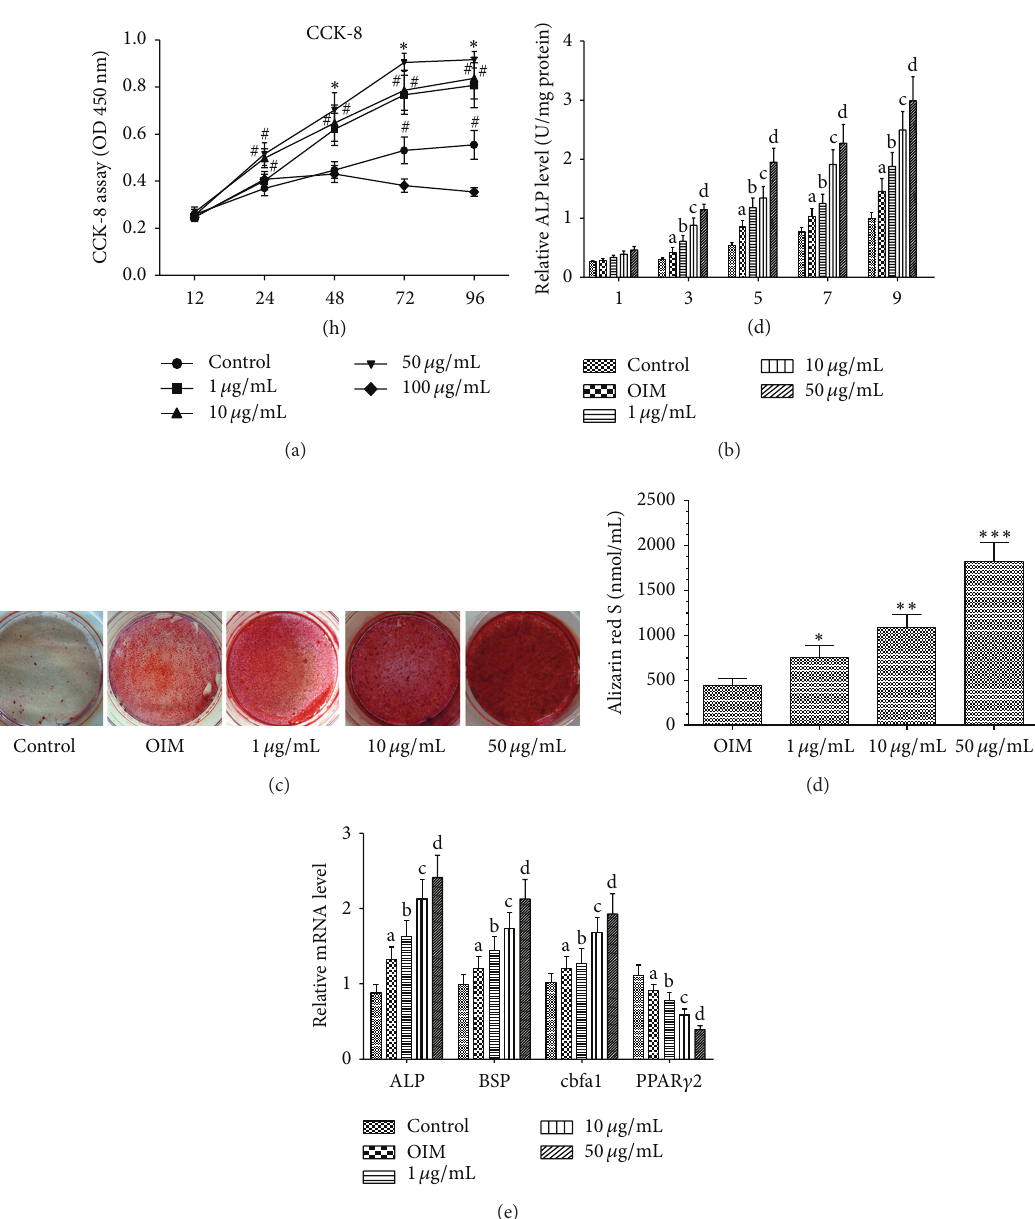
Figure 1: Naringin potentiates proliferation and osteogenic differentiation of BMSCs. (a) BMSCs were cultured in basal medium with or without various doses of naringin (1, 10, 50, and 100 𝜇 g/mL) for 12–96 hours, and the proliferation rate was assessed by CCK-8 assay. Cell proliferation of BMSCs was enhanced by naringin treatment. Naringin showed the most prominent stimulatory effect on proliferation at 50 𝜇 g/mL. Data is expressed as mean ± SD. Experiments were done in quadruplicate ( 𝑛 = 4 ). ∗ 𝑃 < 0.01 versus the control group; # 𝑃 < 0.05 versus the control group at same time point. (b) BMSCs were cultured in basal medium with or without various doses of naringin (1, 10, 50, and 100 𝜇 g/mL) for 1, 3, 5, 7, and 9 days. Data represent the mean ± SD ( 𝑛 = 4 ). ALP activity was measured by the manufacturer’s instructions. a 𝑃 < 0.05 versus the control group at the same time point; b 𝑃 < 0.01 versus the OIM group at the same time point; c 𝑃 < 0.05 versus the 1 𝜇 g/mL group at the same time point; d 𝑃 < 0.01 versus the 10 𝜇 g/mL group at the same time point. (c) BMSCs were cultured in basal medium and OIM with or without various doses of naringin (1, 10, and 50 𝜇 g/mL) for 21 days; then calcium deposits were stained with Alizarin red S solution. For quantitative analysis, the stained samples underwent cetylpyridinium chloride (CPC) extraction (10% CPC) and extracts were measured by spectrophotometry. Data represent the mean ± SD ( 𝑛 = 5 ). ∗ 𝑃 < 0.01 versus the OIM group; ∗∗ 𝑃 < 0.05 versus the 1 𝜇 g/mL group; ∗∗∗ 𝑃 < 0.01 versus the 10 𝜇 g/mL group. (e) BMSCs were cultured in basal medium, OIM, or OIM with 1 𝜇 g/mL, 10 𝜇 g/mL, or 50 𝜇 g/mL naringin for 14 days, and then ALP, BSP, Cbfa1, and PPAR 𝛾 2 mRNA levels were measured by RT-PCR. Data represent the mean ± SD ( 𝑛 = 5 ). a 𝑃 < 0.05 versus the control group; b 𝑃 < 0.05 versus the OIM group; c 𝑃 < 0.01 versus the 1 𝜇 g/mL group; d 𝑃 < 0.01 versus the 10 𝜇 g/mL